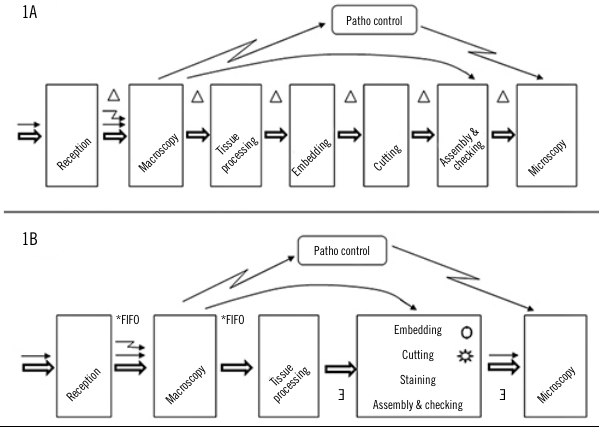
figuRE 1 − Graphic representation of VSM for the pre-analytical process at the pathology laboratory of Haroldo Juaçaba Hospital (PL-ICC) A) VSM-2013: an interrupted workflow, and lack of standardization between the compartmentalized tasks were pointed; B) VSM-2014: as the main gains from Lean philosophy implementation we can cite the incorporation of some tools as supermarket ( ᴲ ); FIFO ( ∆ ); continuous workflow ( Ѻ ); and expertise sharing ( ☼ ) at the histotechnology area, representing an unification of the following tasks: “embedding”, “cutting”, “staining”, and “assembly and checking” of stained slides. VSM: value stream mapping; PL-ICC: Pathology Laboratory of Instituto do Câncer do Ceará; FIFO: first in, first